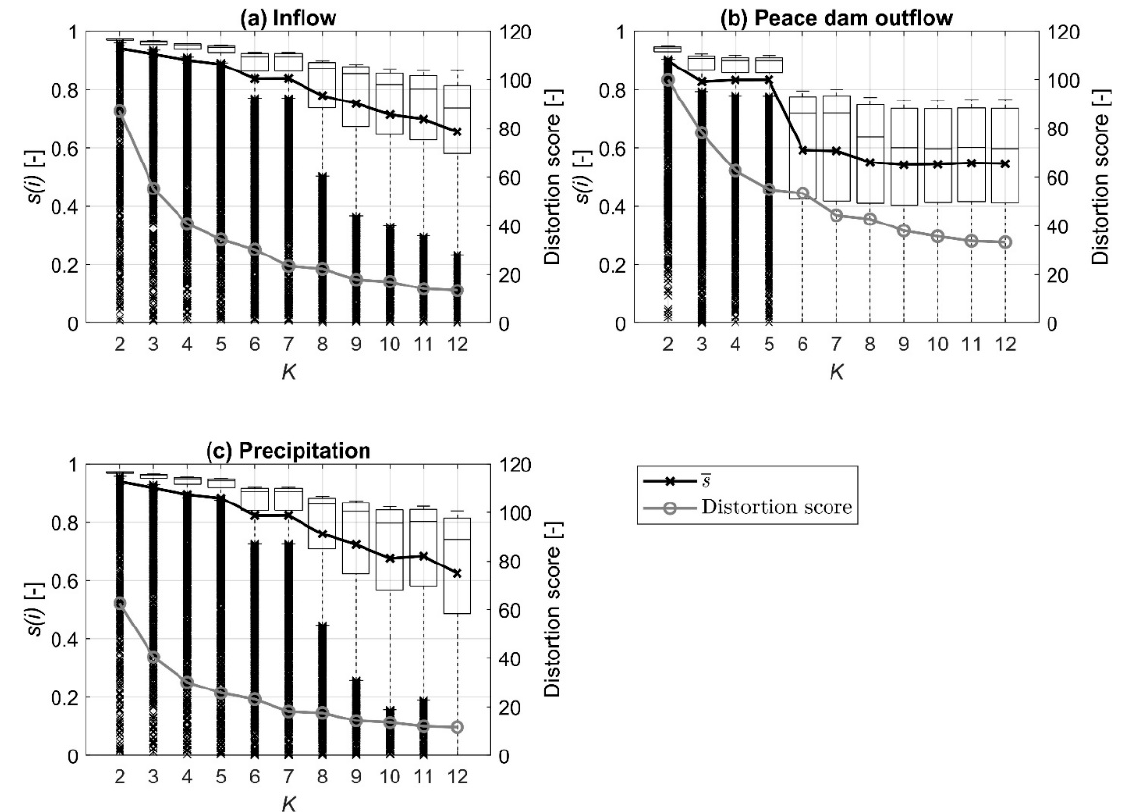
Figure 8. Silhouette coefficient s ( i ) versus the number of clusters ( K ) used in K -fold cross-validation. Boxplots are drawn from 5260 s values (i.e., i = 5260) corresponding to the entire length of training and validation dataset for the three principal variables (i.e., Qin, Qo, and Pr). The boxplots demonstrate the median (central mark), the 25th and 75th percentiles (the edges of the box), and the maximum and minimum (the upper and lower whiskers) except for outliers (cross symbols). The black-cross line ( s ) demonstrates the average values of s ( i ) . The gray lines on the right axis represent the ‘distortion score’ computed in the elbow method.